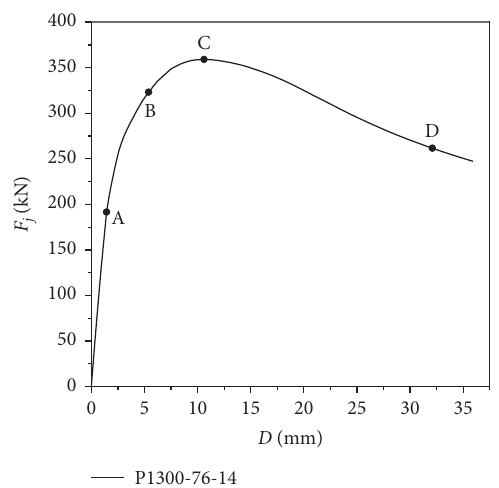
Figure 15: F − D (displace) curves of the model j